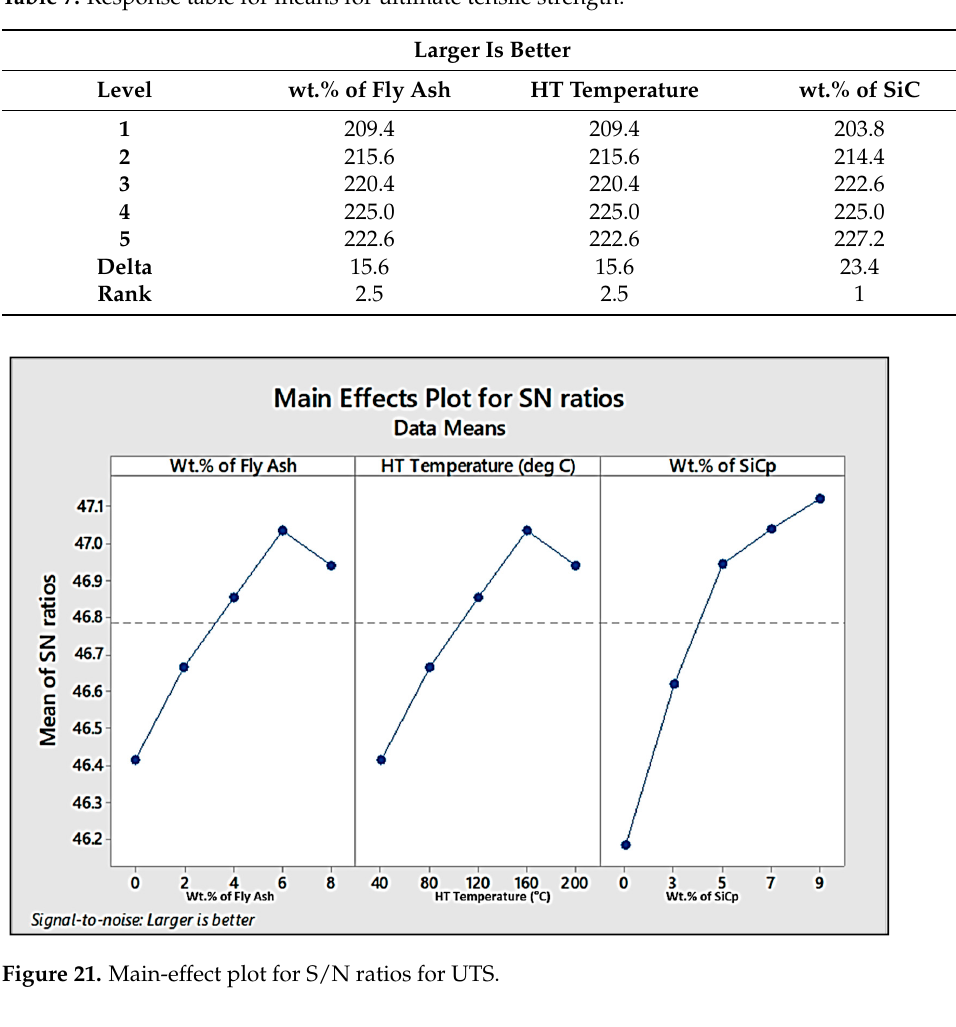
Materials 2021 , 14 , x FOR PEER REVIEW Figure 21. Main-effect plot for S/N ratios for UTS. Figure 21. Main-effect plot for S/N ratios for UTS.